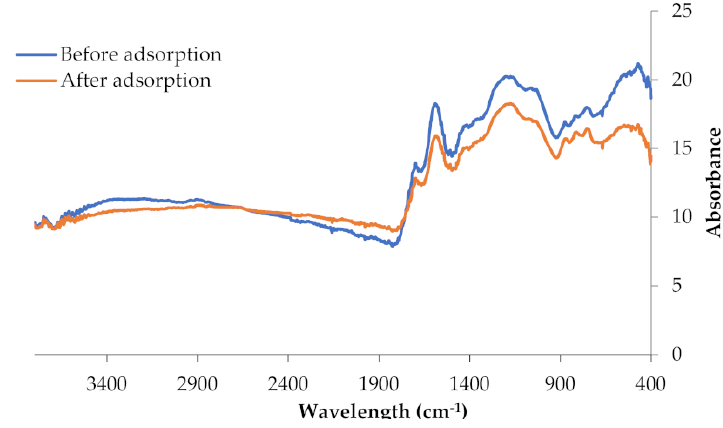
Figure 5. Characterization of burnt pine wood by FTIR-ATR